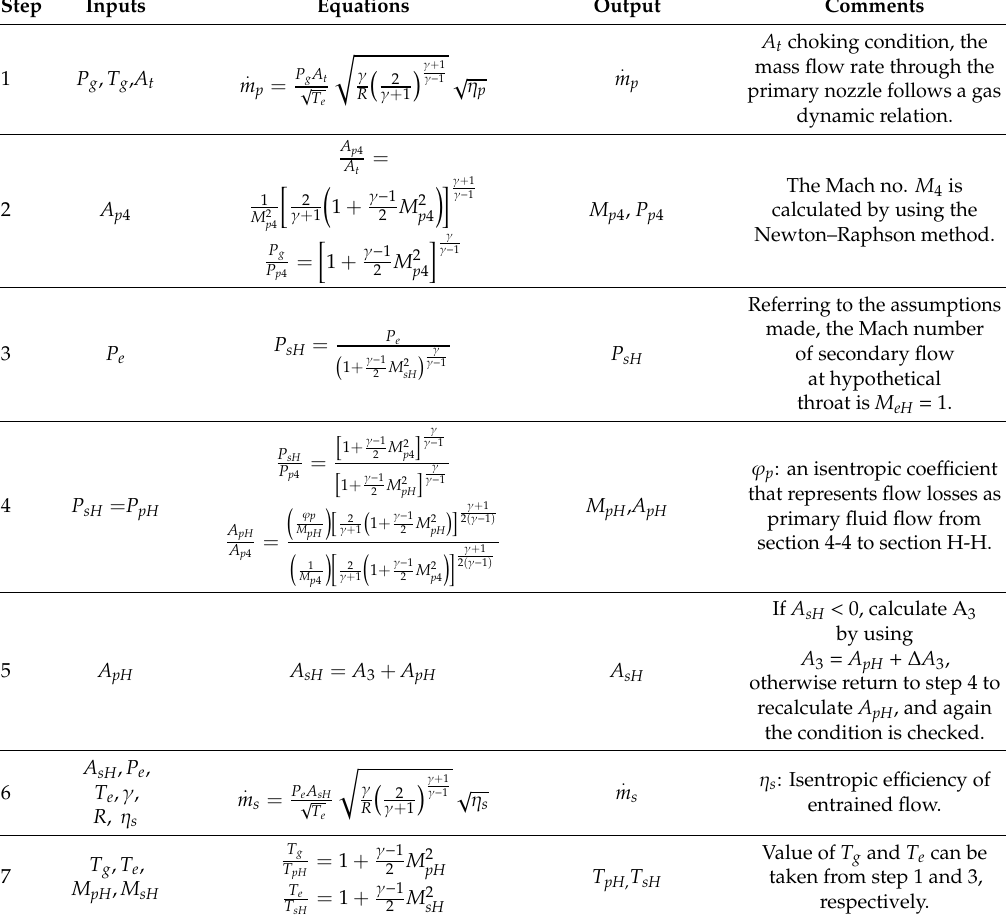
Table 2. Conventional calculation